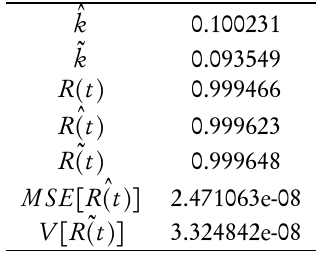
Estimates of k and R(t), variance and MSE under type II censoring.